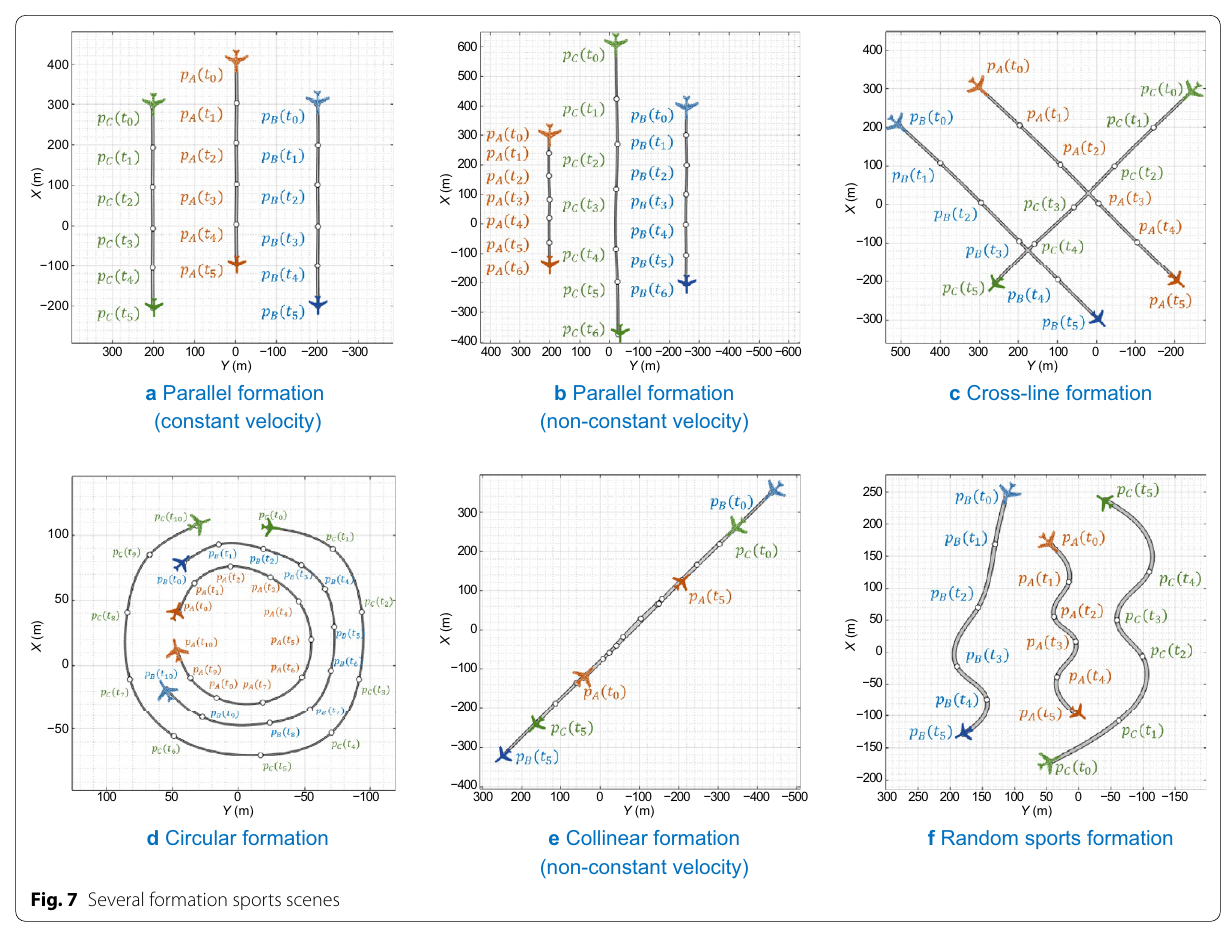
Fig. 7 Several formation sports scenes